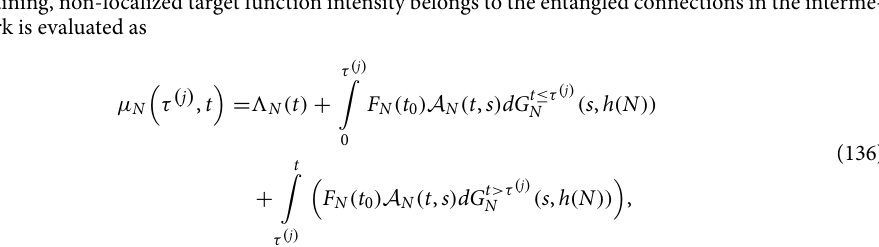
( j ) t , t survival amplitude of the � B 0 (cid:31) (cid:30)